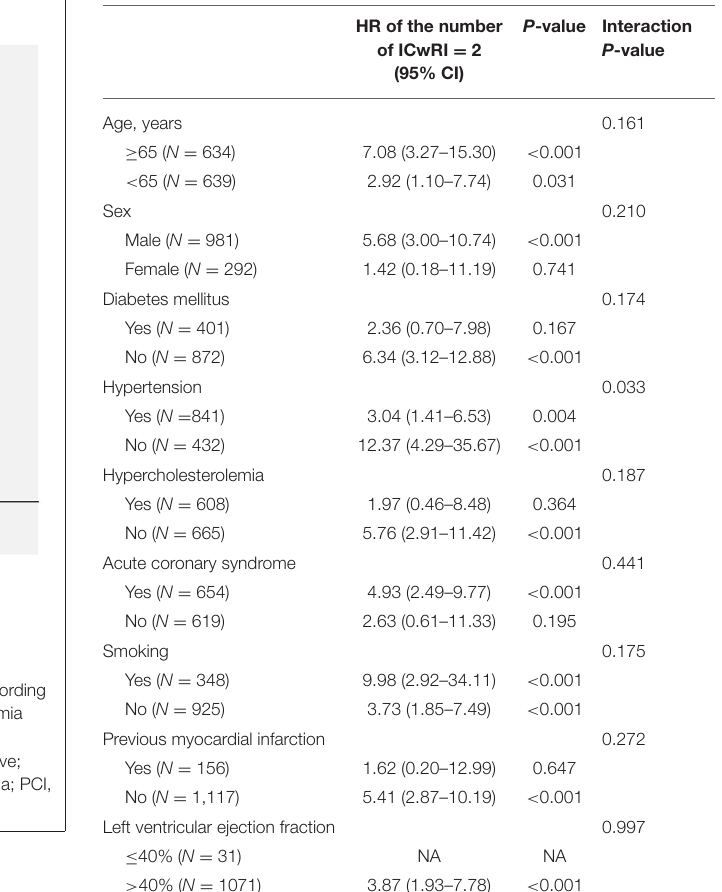
TABLE 4 | Prognostic implications of ICwRI among patients without residual ischemia according to their clinical